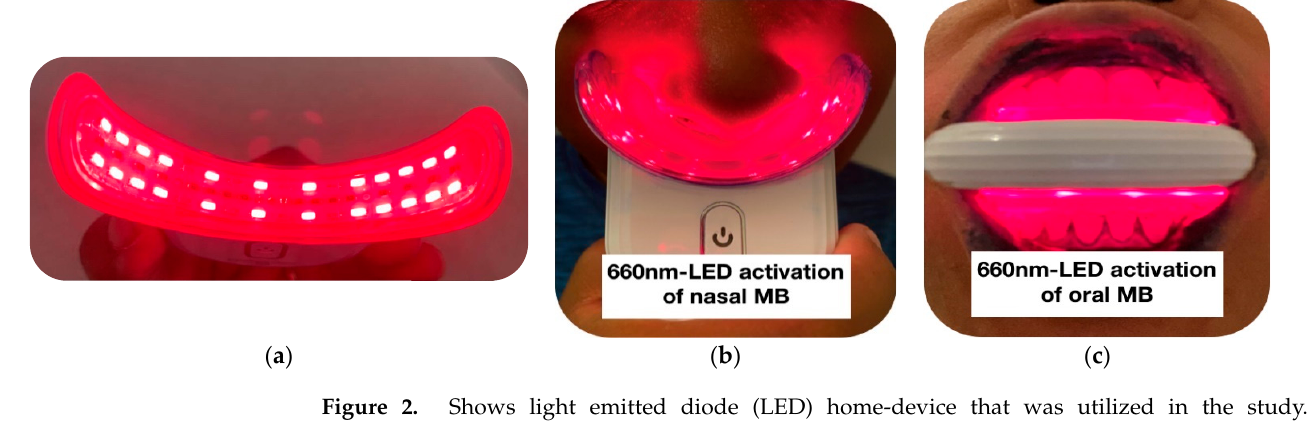
Figure 2. Shows light emitted diode (LED) home-device that was utilized in the study. Photo ( a ): shows the device illumined with 24 LEDs. Photos ( b , c ) illustrate the device application underneath the nostrils and inside the oral cavity, respectively, and were illuminated after methylene blue (MB) solution was topically administered in both cavities.